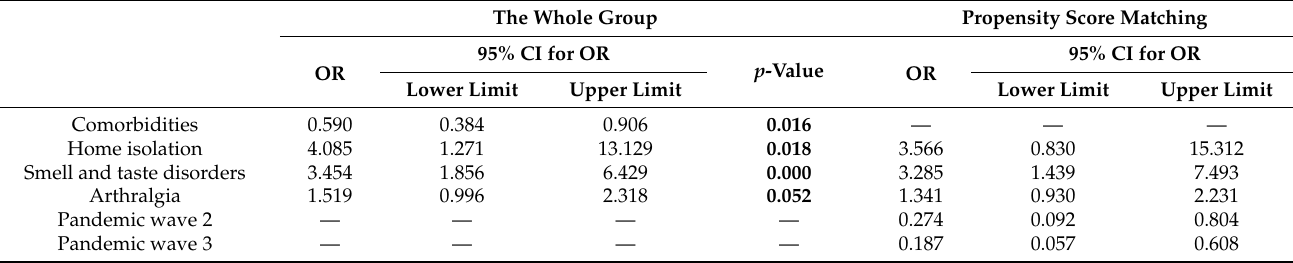
Table 4. Multivariate analysis based on a model incorporating statistically significant predictors from univariate analysis on the risk of developing persistent smell and taste disorders. The Whole Group Propensity Score Matching 95% CI for OR 95% CI for OR p -Value OR OR Lower Limit Upper Limit Lower Limit Upper Limit